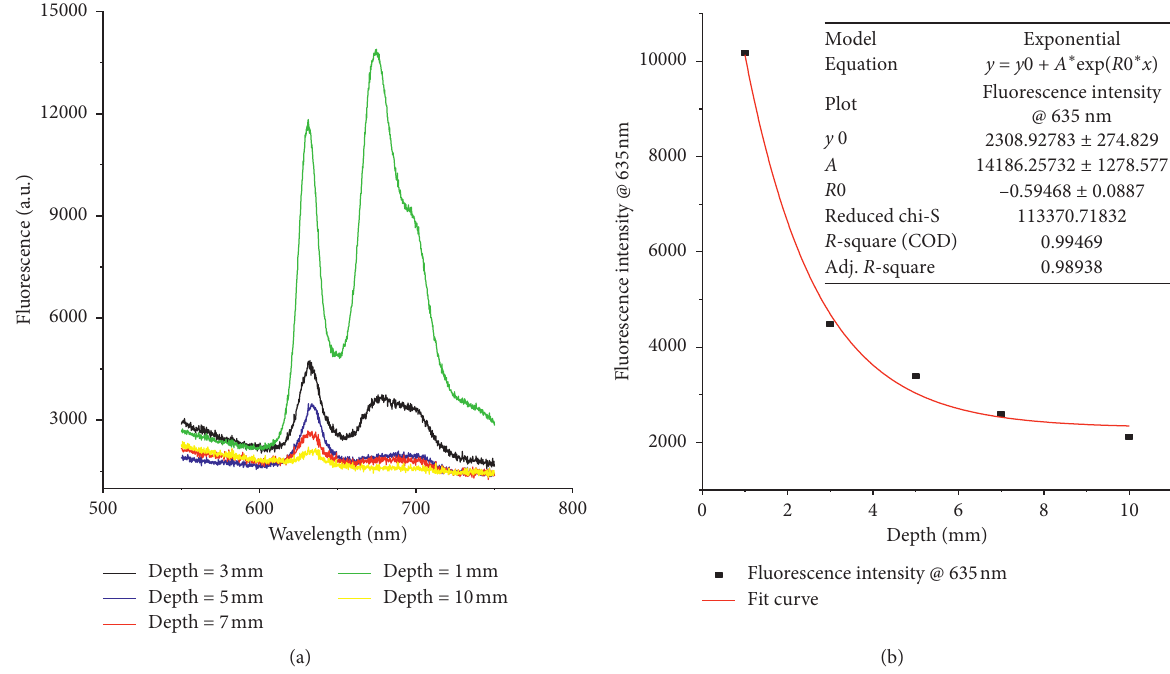
Figure 3: (a) Recordings of fluorescence spectra for different depths of the PpIX inclusion. (b) Fluorescence intensity at 635nm for different depths of the PpIX inclusion in the optical phantom. Fitted curve shows exponential behaviour of the fluorescence intensity as a function of the